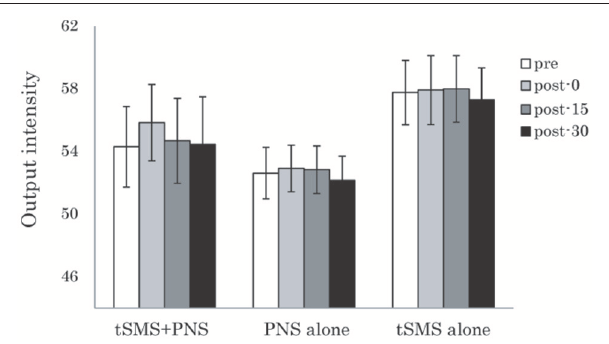
FIGURE 3 | Effects of the combination of tSMS and PNS on the rMT measured in the right APB muscle. There were no significant changes of right APB. Error bars are standard errors of the